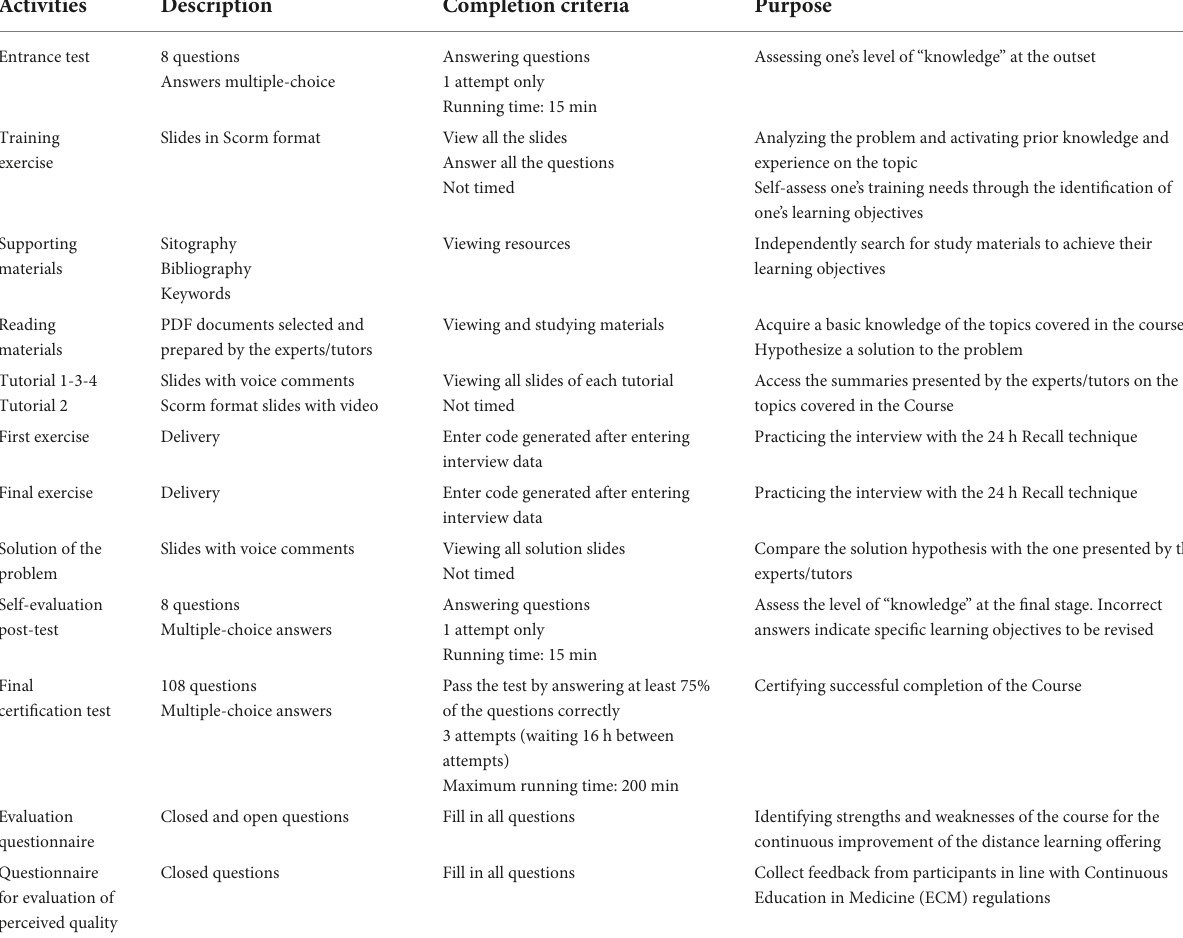
TABLE 2 Detailed description of activities, completion criteria and purpose of medium interaction distance learning